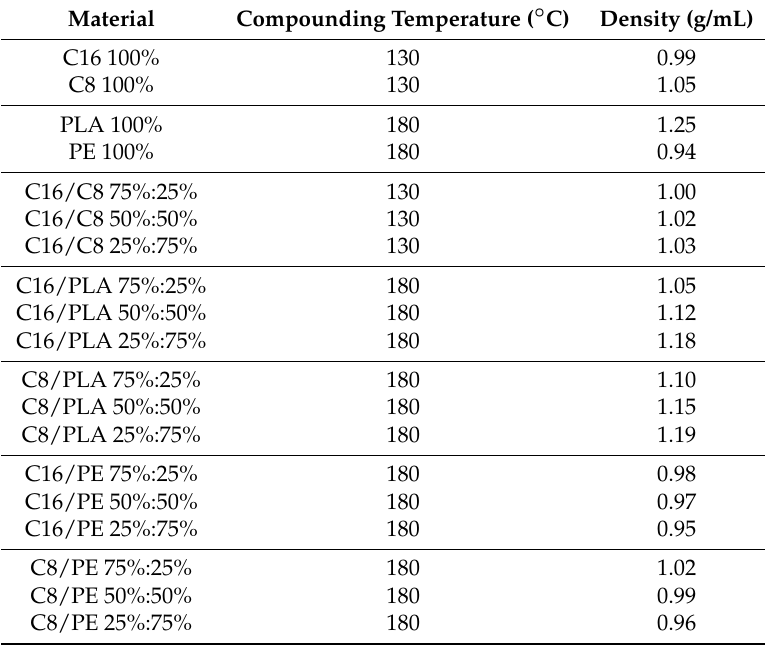
Table 1. Compounding temperatures and densities of compounded